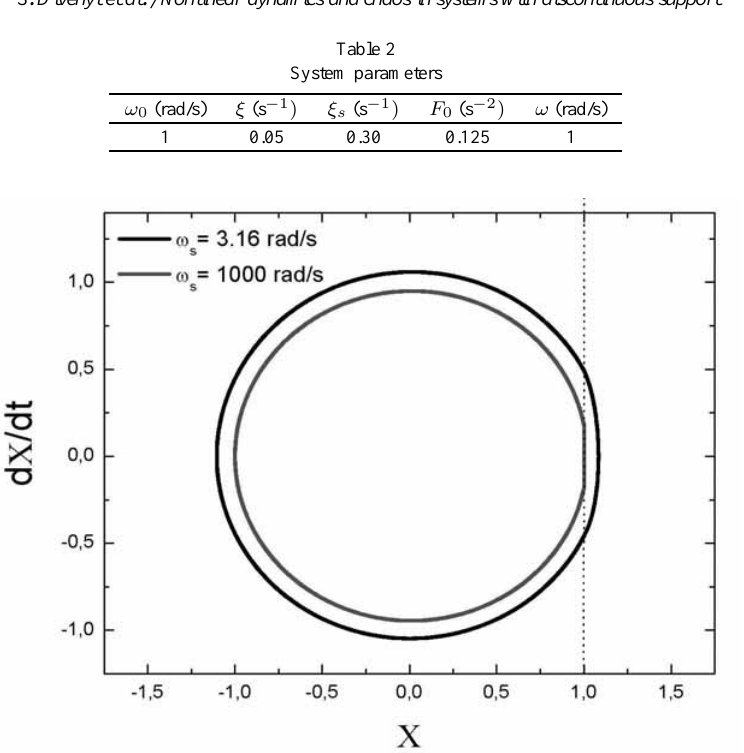
Fig. 5. Response for different support